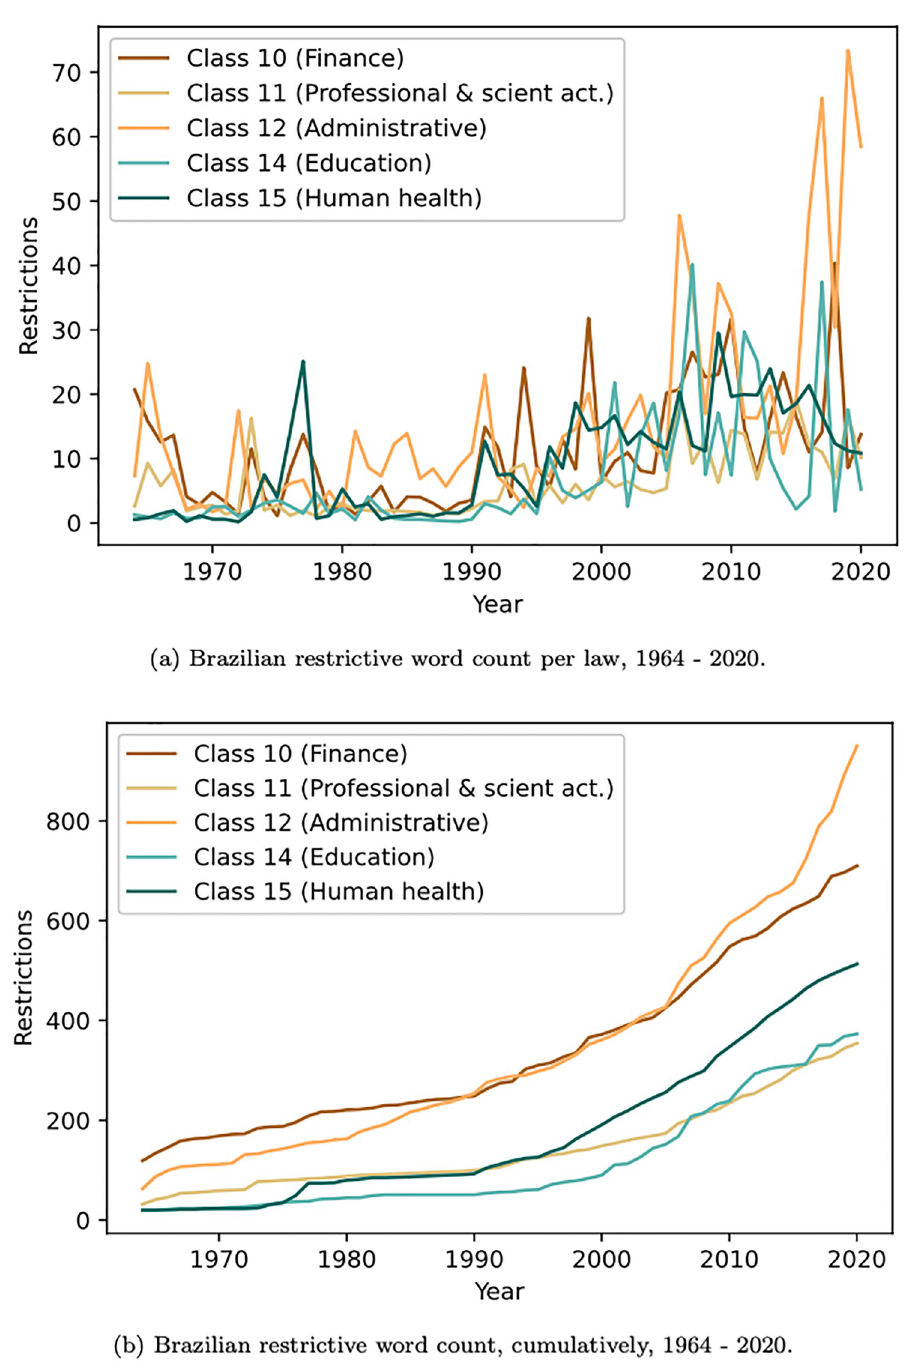
Fig 5. Brazilian restrictive word